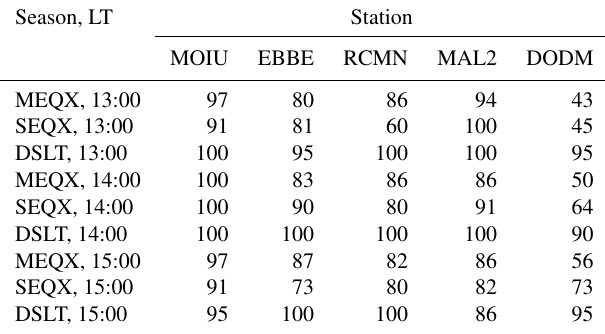
Table 4. Percentage of prominent EIA corresponding to threshold EEJ